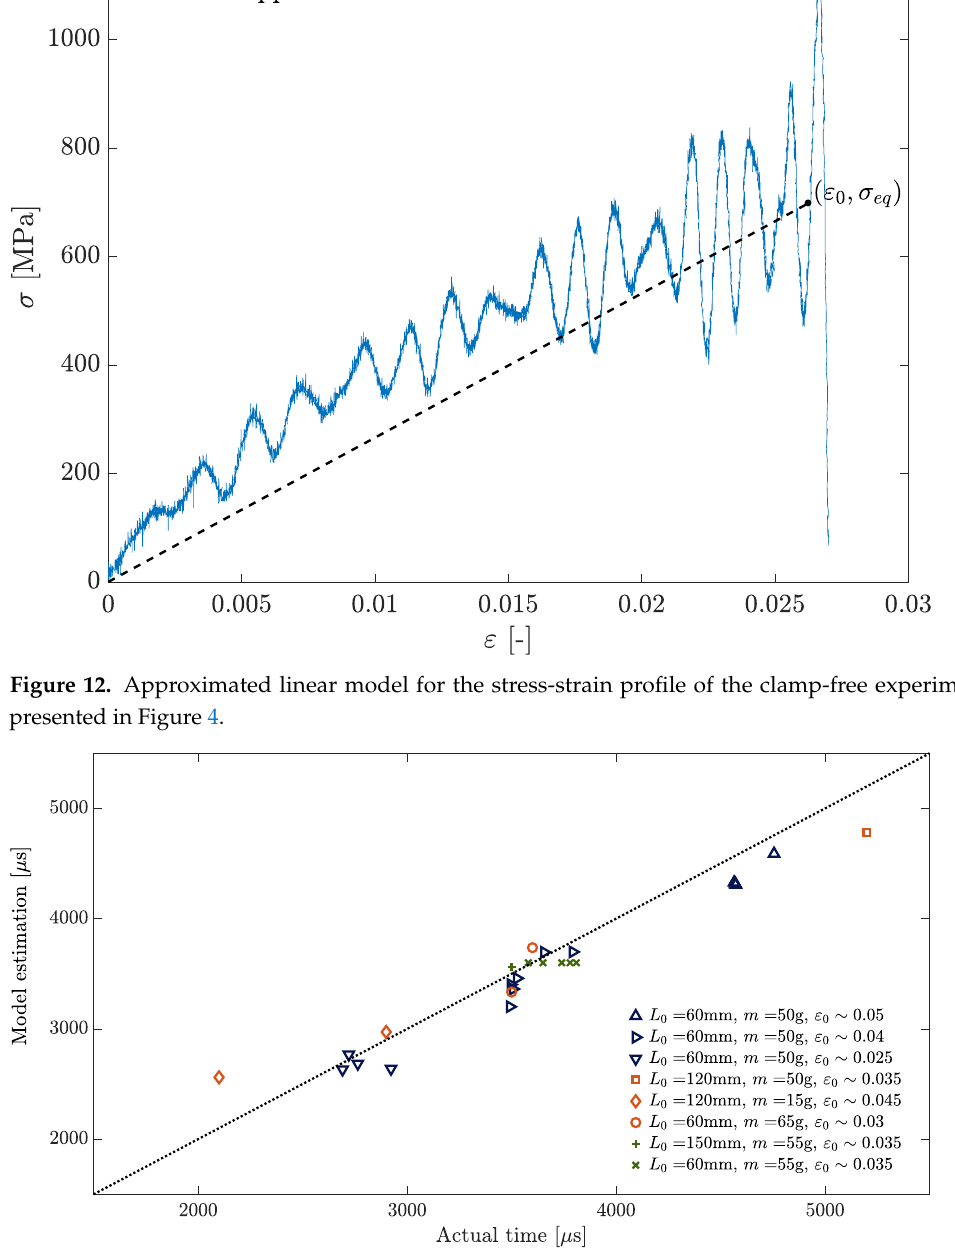
Figure 13. Duration of Actuation—predictive model versus actual tests. Data was taken from experiments reported in Refs.